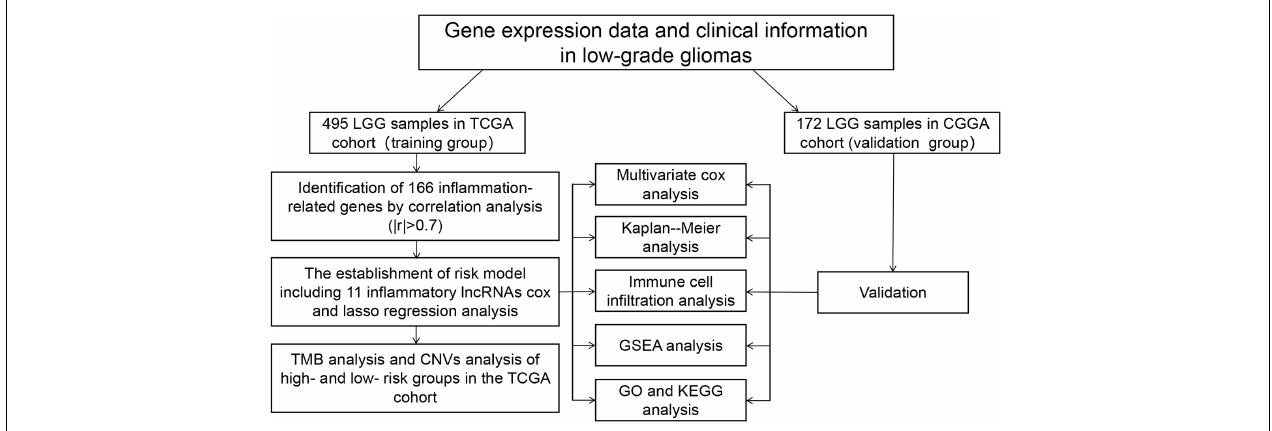
FIGURE 1 | Analysis flow